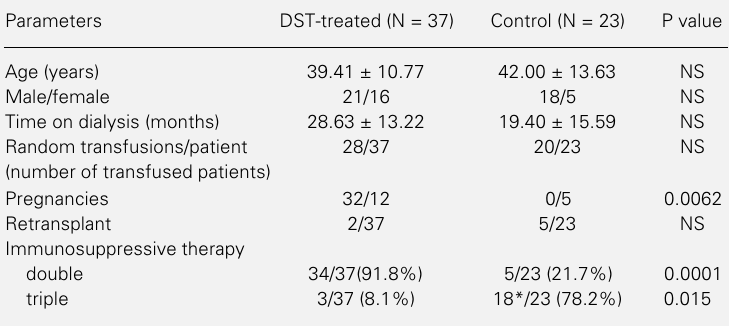
Table 1 - Comparison between DST-treated (transfused group) and control (nontransfused group) patients. *Two of 18 patients received quadruple therapy. NS,